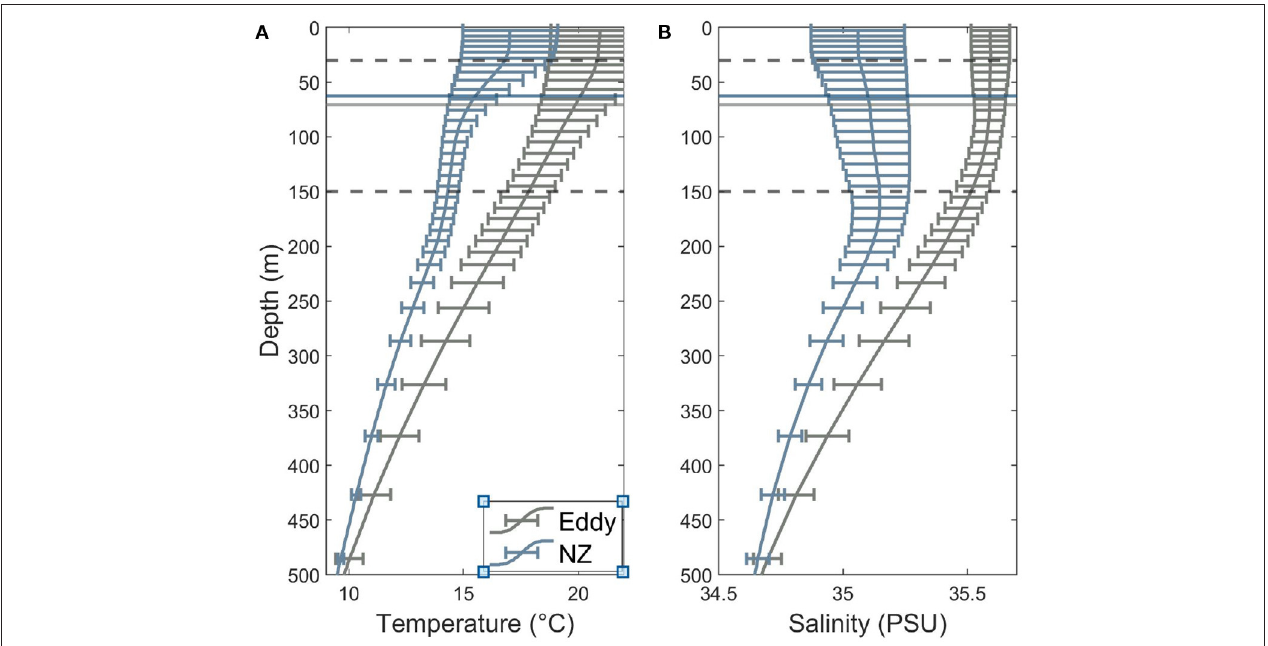
FIGURE 2 | Mean temperature (A) and salinity (B) for the Eddy box (grey) and NZ box (blue). MLD 30 and MLD 150 are marked by dashed black lines and the mean SML depth (MLD V ) per region is marked by solid horizontal lines.